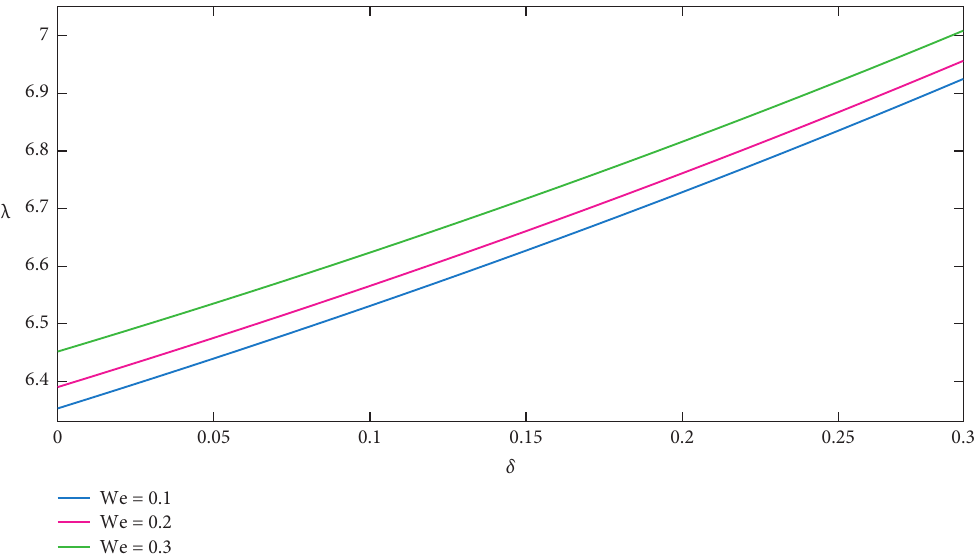
Figure 2: Variation of resistance for the Carreau model for m � 2 , n � 2 , L � 1 , and F � 0 .